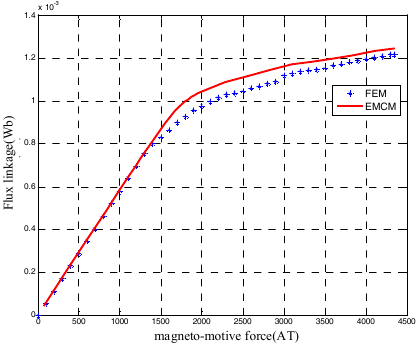
Figure 6. Comparison of flux linkage at aligned position between analytical solution and numerical solution of finite-element method (FEM).